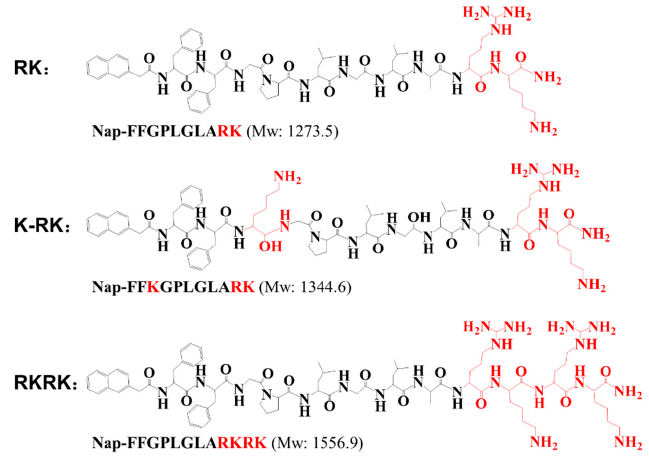
Figure 1. Molecular structures of the peptides used as capping agents for ZIF-8 synthesis.